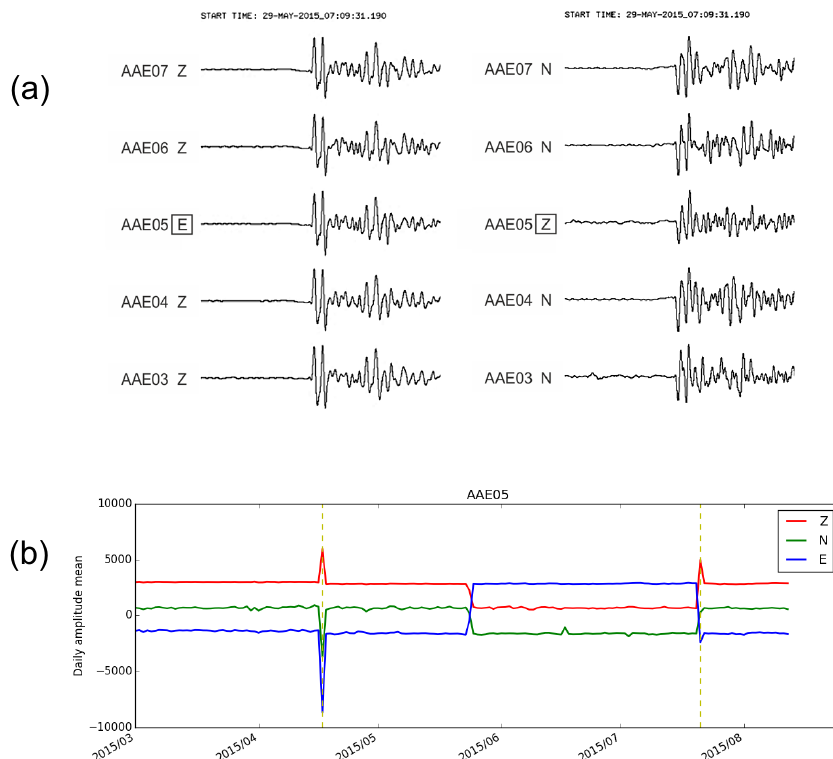
Figure 9. The waveform similarity method showing the interchange of the EW and Z components (a) at the AAE05 station. Daily amplitude means (b) of all three components at the AAE05 station during June–July 2015 indicate the interchange of all three components. Vertical dashed lines show dates of station